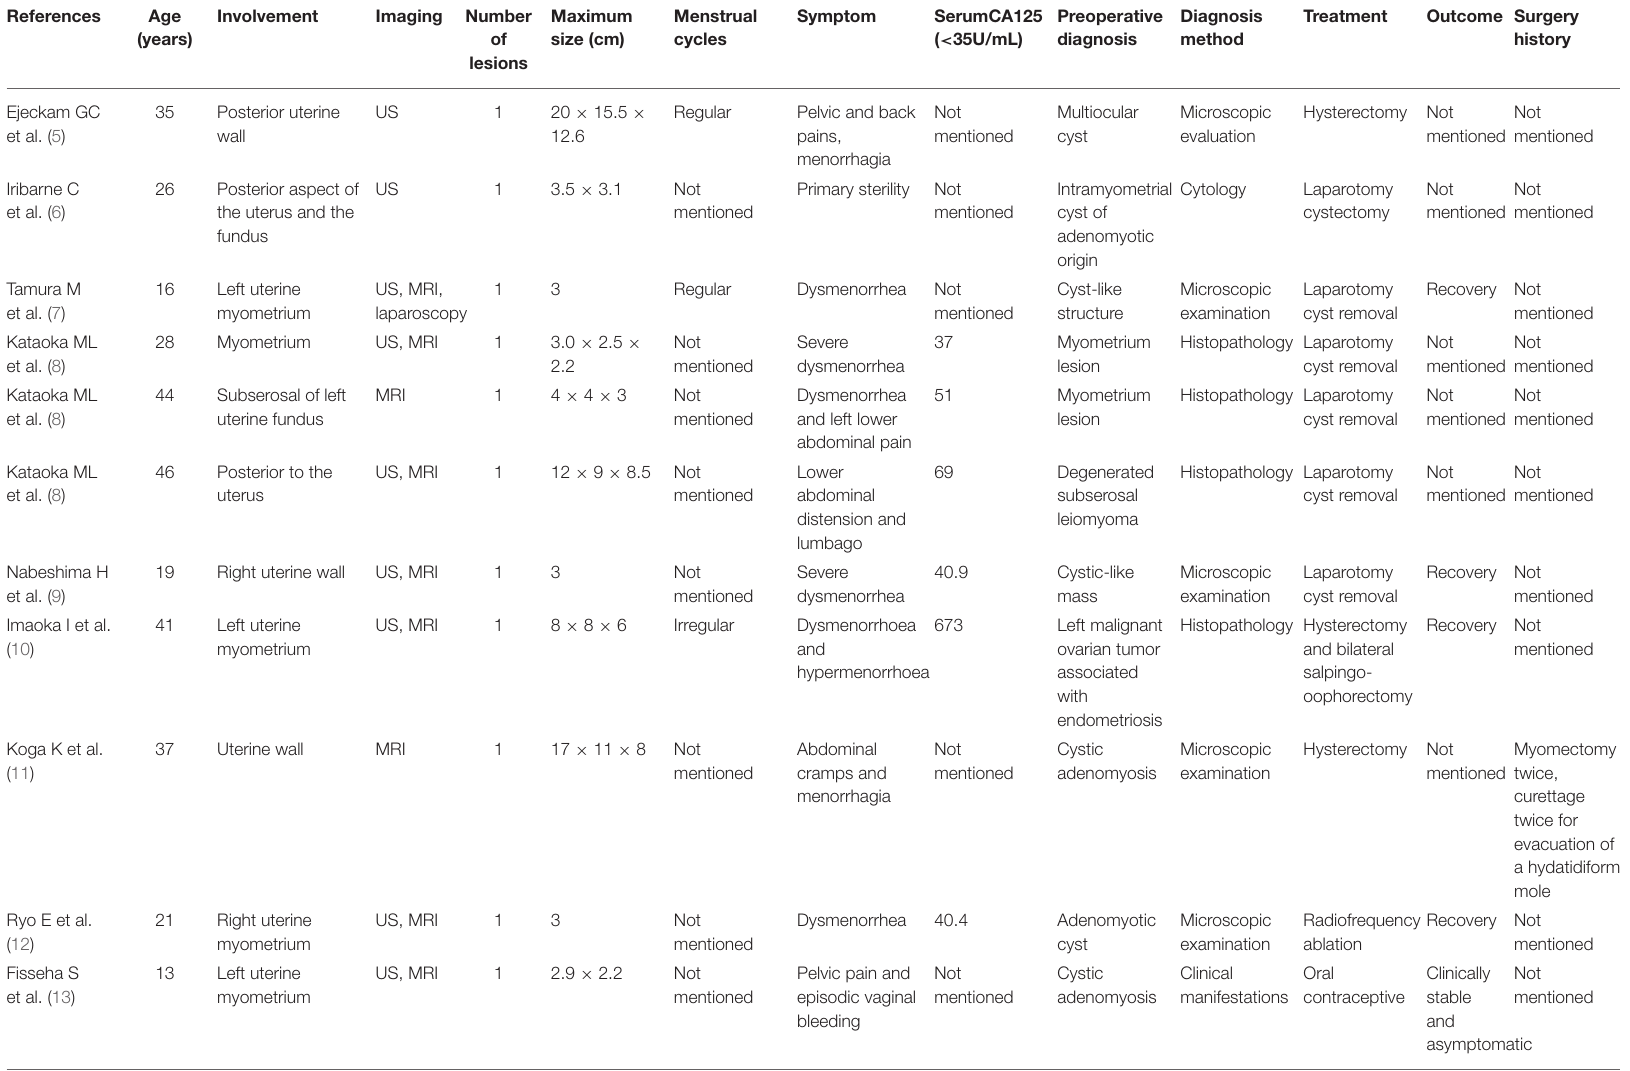
TABLE 1 | Case reports of uterine cystic